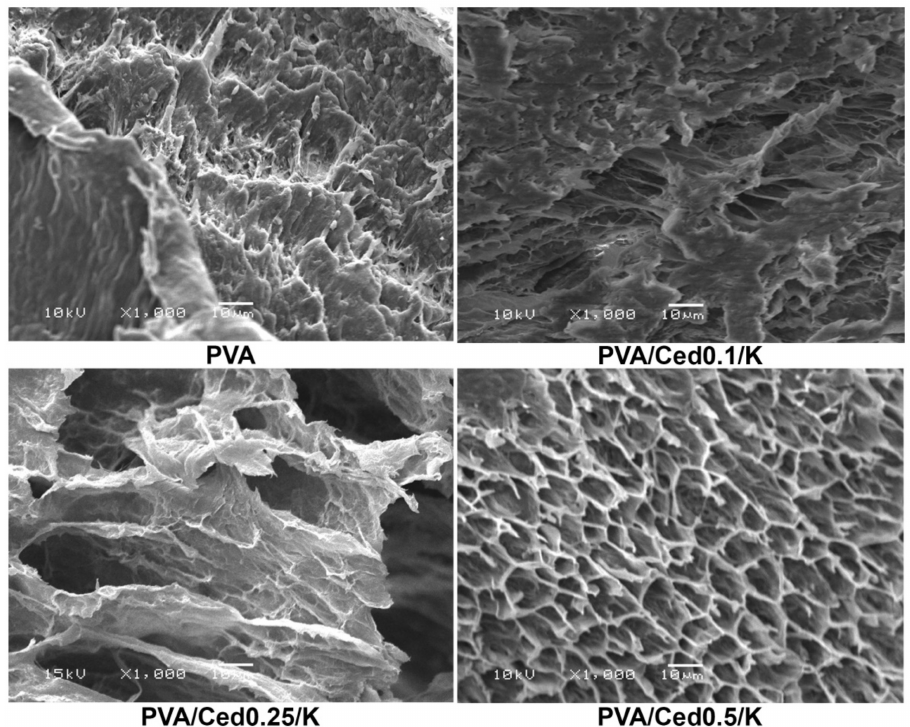
Figure 3. SEM images of cross-sectional areas of composite sponges at a magnification of 1000 ×